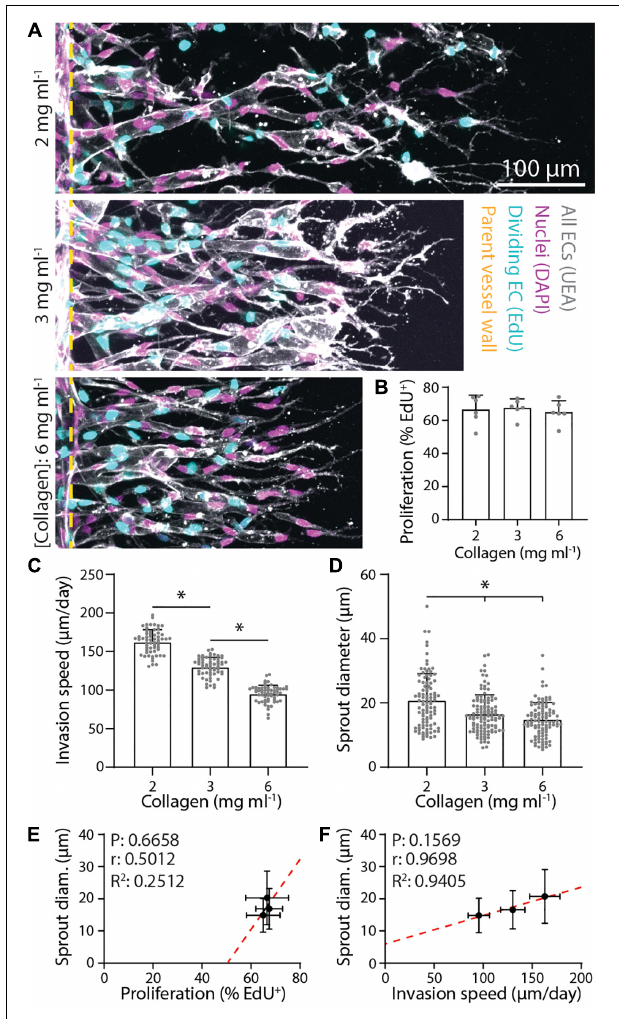
FIGURE 3 | Denser matrix that slows sprout invasion leads to smaller sprout diameters. (A) Representative images (max intensity projections) of invading endothelial cells (ECs) in response to varying collagen density. All conditions were cultured for 3 days with 250 nM sphingosine 1-phosphate (S1P) in endothelial cell growth medium 2 [EGM2; supplemented with 25 ng ml − 1 phorbol 12-myristate 13-acetate (PMA)] added to the chemokine channel within collagen hydrogels of the indicated density. Nuclei (magenta), 5-ethynyl-2 (cid:48) -deoxyuridine (EdU; cyan), Ulex Europaeus Agglutinin-1 (UEA; white), and yellow dashed lines indicate parent vessel edge. (B–D) Quantifications of proliferation, invasion speed, and sprout diameter as a function of collagen hydrogel density. For proliferation: n ≥ 6 per condition, for invasion speed: n ≥ 60 per condition, and for sprout diameter: n ≥ 100 per condition. (E,F) Relationships between proliferation and sprout diameter (E) and invasion speed and sprout diameter (F) , with red dashed lines indicating a linear regression and statistical analyses performed by Pearson’s correlation. Sample size for each mean is identical to those of panels (B–D) . All data presented as mean ± SD; *indicates a statistically significant comparison with P < 0.05 (one-way